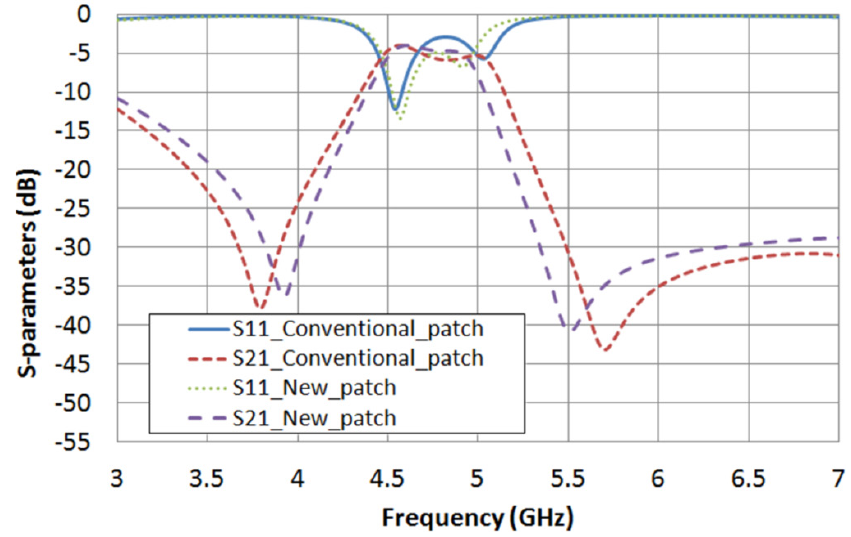
Figure 11. S-parameters obtained in simulation for both structures considering ε and tan δ = 0.02. ‖